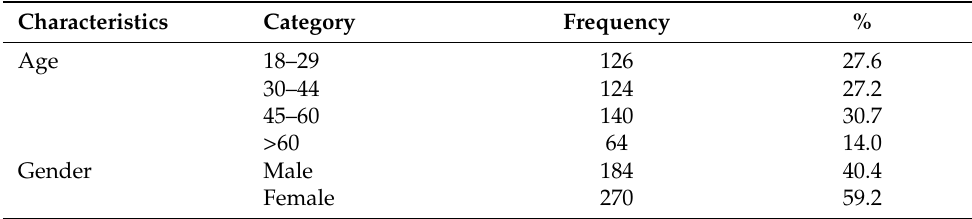
Table 1. Profile of the respondents ( n = 454).